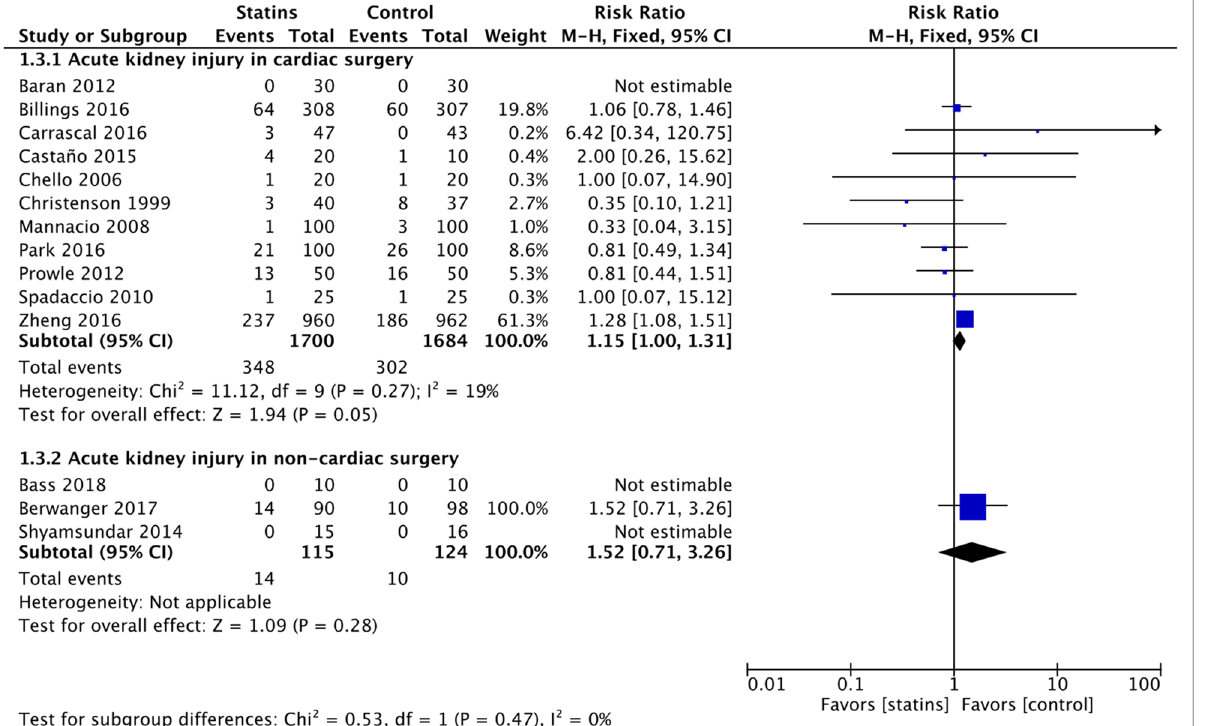
Fig. 5 Postoperative acute kidney injury (AKI). Forest plot for postoperative AKI in patients with perioperative statin therapy versus